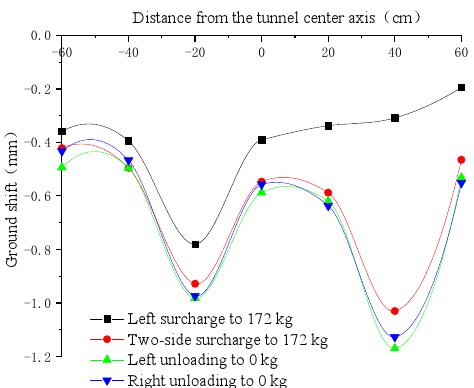
Figure 10. Variation in ground shift under different surcharges for Case 1.